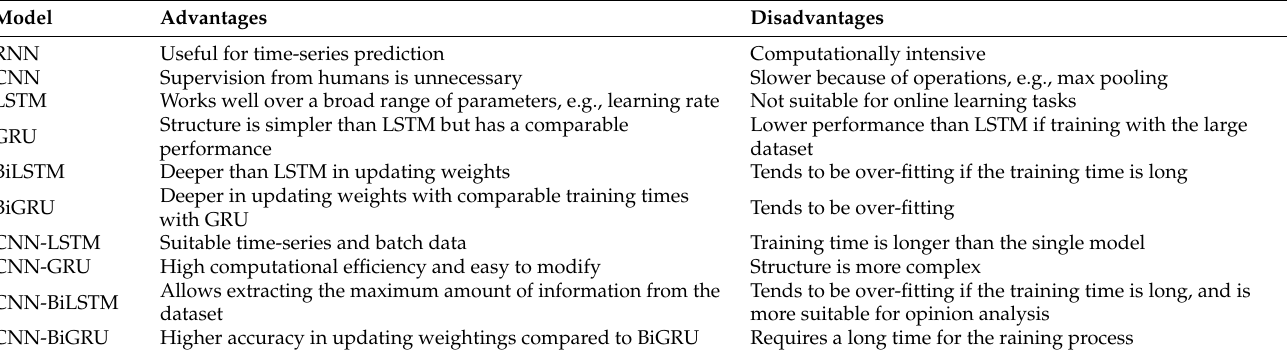
Table 8. A summary of the advantages and disadvantages of the proposed deep learning